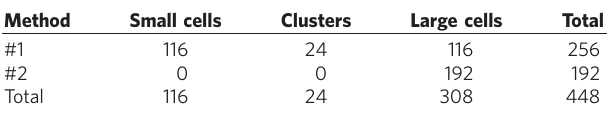
Table 1 | Summary of samples selected for